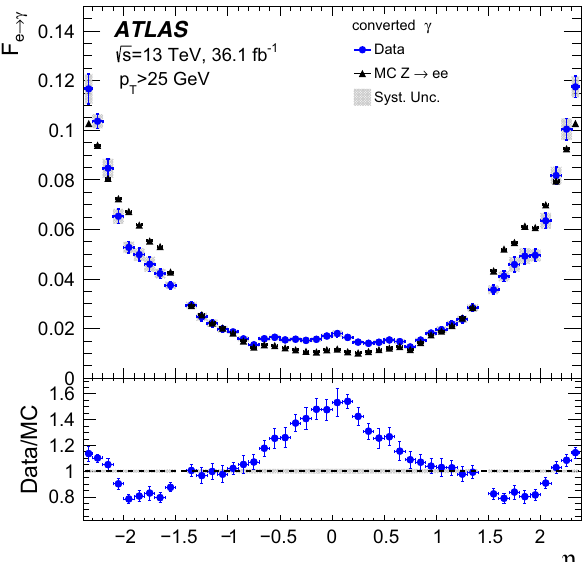
Fig. 17 Evolution of the e → γ fake-rate as a function of η for elec- trons reconstructed as unconverted (left) and converted (right) photon candidates, in data (circles) and Z → ee MC events (black triangles). Symbols with error bars correspond to the results with their total uncer-